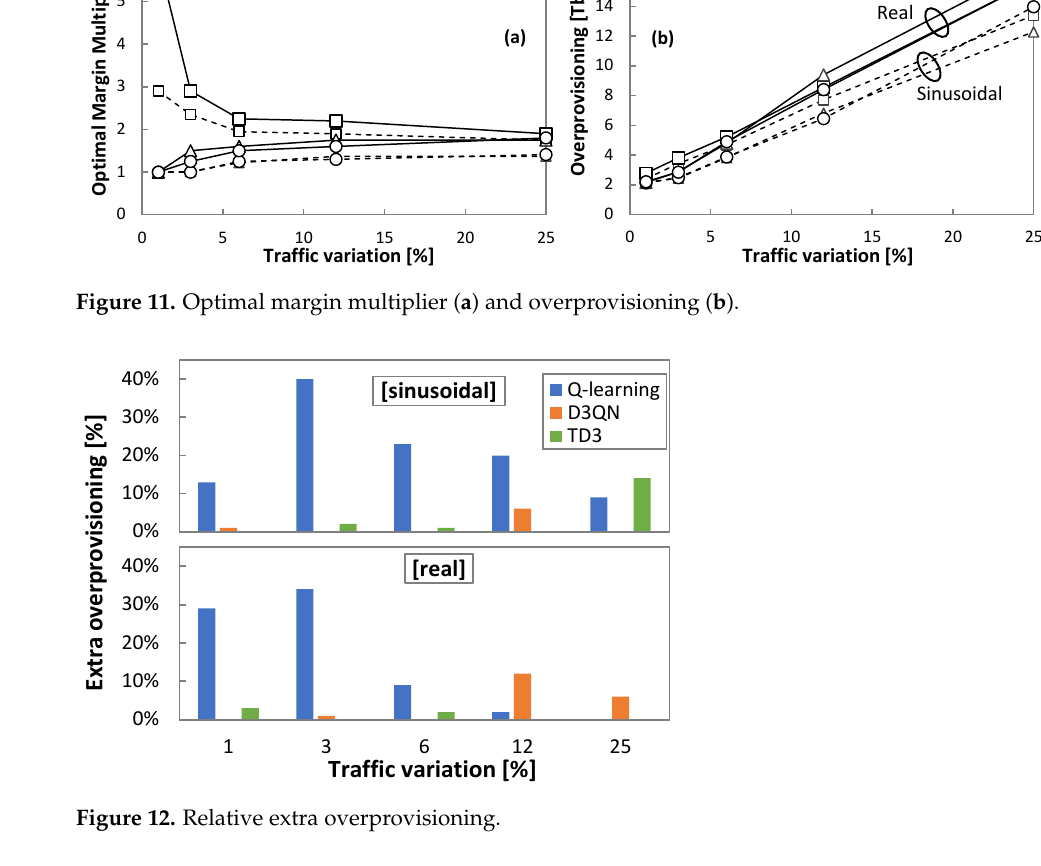
Table 3. Additional overprovisioning when fixing ρ conservatively.